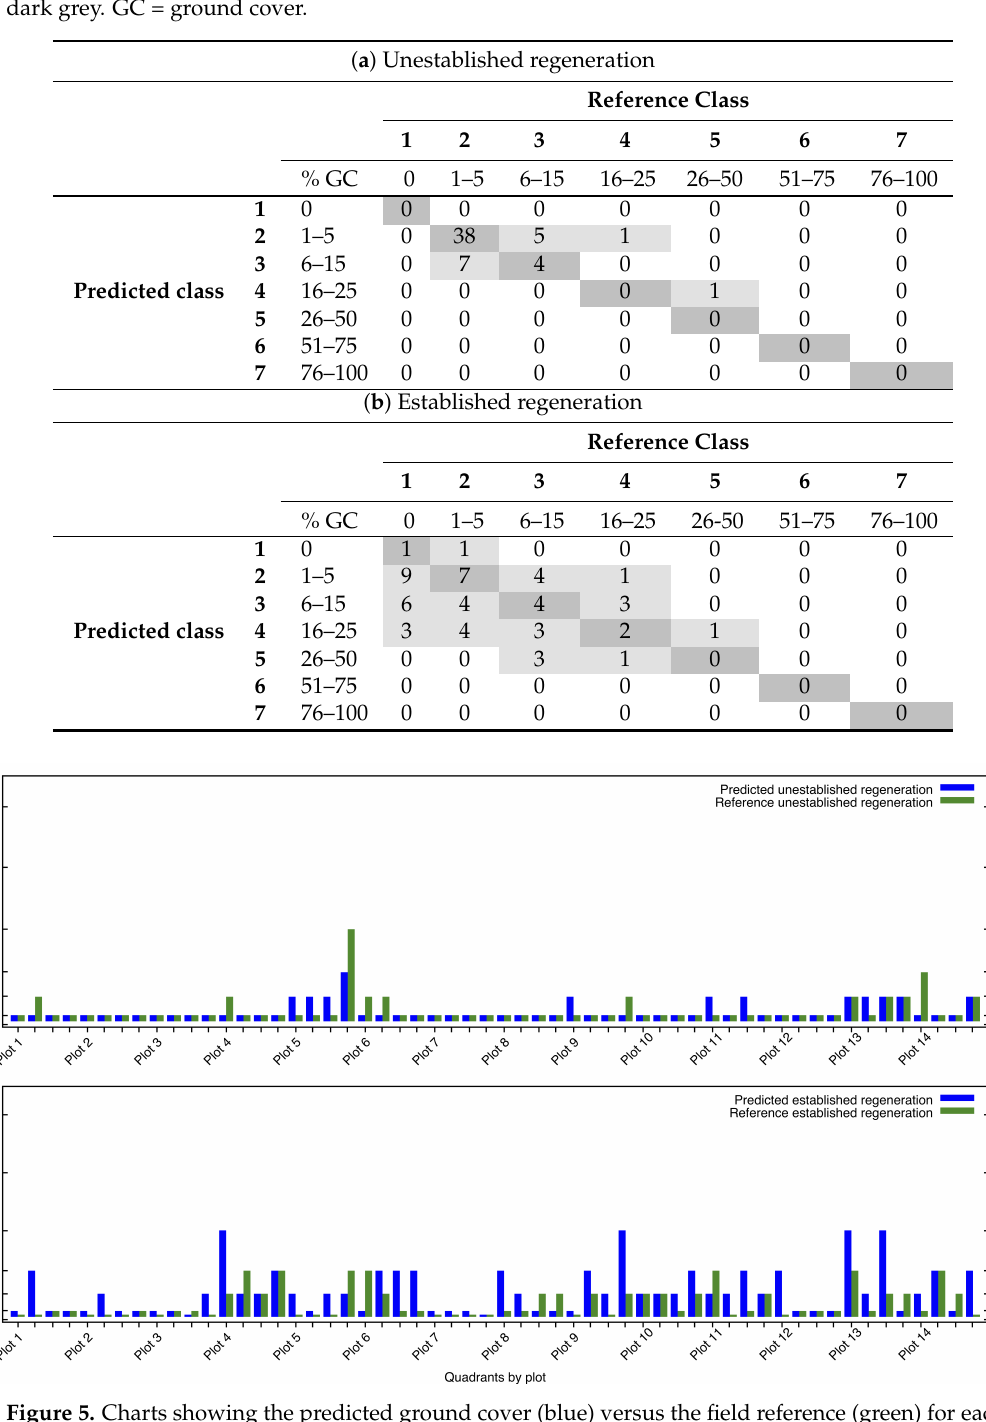
Table 2. Confusion matrices summarizing the results of the accuracy assessment. The two subtables separately describe the results for ( a ) unestablished and ( b ) established regeneration. The matrices contain the counts of occurrences for each combination of reference and predicted class. All class combinations outside the matrix diagonal are highlighted in light grey, while the matrix diagonal is in dark grey. GC = ground cover.